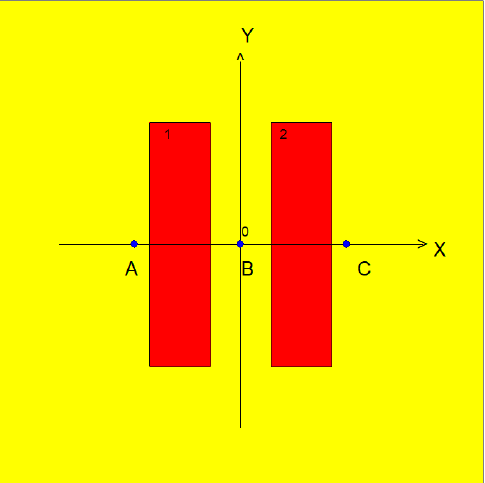
Figure 2. Scheme of control